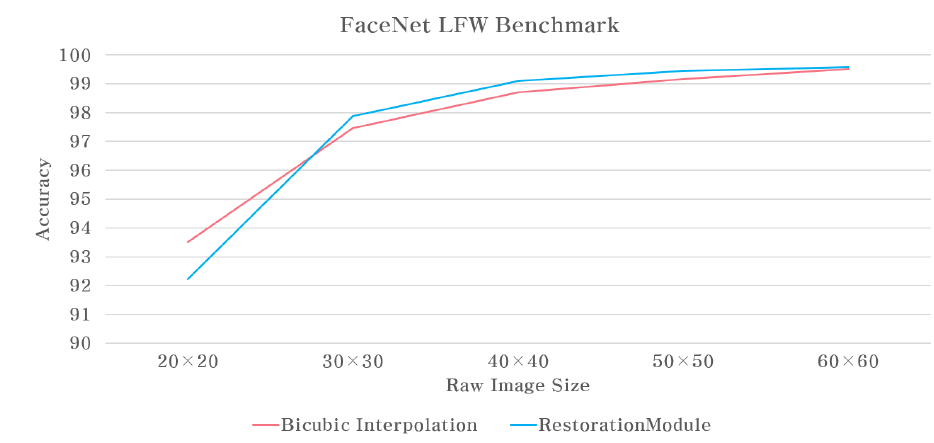
Figure 7. The comparison of the identification performances of the restored images using the bicubic interpolation method and the image restoration module. The FaceNet default settings are used to extract the identification performance. The vertical axis represents the accuracies and the horizontal axis is the size of the original image to be